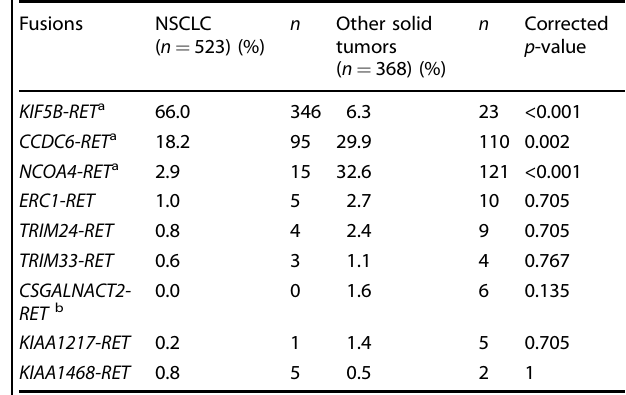
Table 3. Comparative Genomics: Prevalence of RET fusions and partner genes among RET fusion-positive NSCLC and other solid tumors (fusions with at least 5 cases, for fusions with less than 5 cases please see Supplementary Table